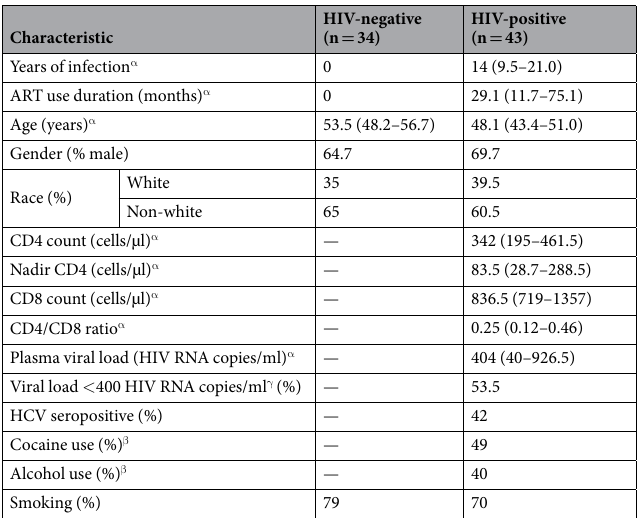
Table 1. Demographic and clinical characteristics of the study cohort. α Median (Interquartile range). β Based on patient report. γ Viral load below limit of detection. ART = Antiretroviral therapy, HCV = hepatitis C virus, –Not